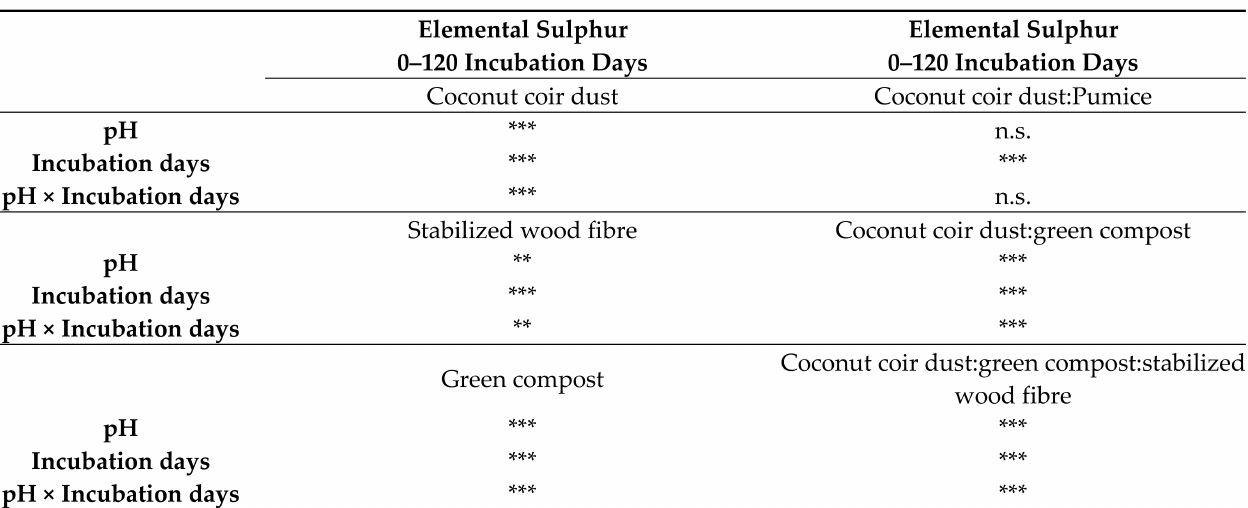
Figure 3. pH trend of the different matrices (coconut coir dust, stabilized wood fibre, and green compost) and of the chosen growing media during the test in field condition with elemental sulphur chips using the dosages calculated through the titration curve for lowering the pH. − 1.5 pH point adjustment is referred to coconut coir dust and stabilized wood fibre, while − 2 point pH adjustment is referred to green compost and to growing media. Mean separation across time within each addition rate and across dosage at the same time was performed by two-way analysis of variance (ANOVA analysis in table: n.s., not significant; * p ≤ 0.05; ** p ≤ 0.01; *** p ≤ 0.001). Different letters indicate significantly different values (Tukey’s multiple comparisons test). Each data point is the mean of three replicates ± standard